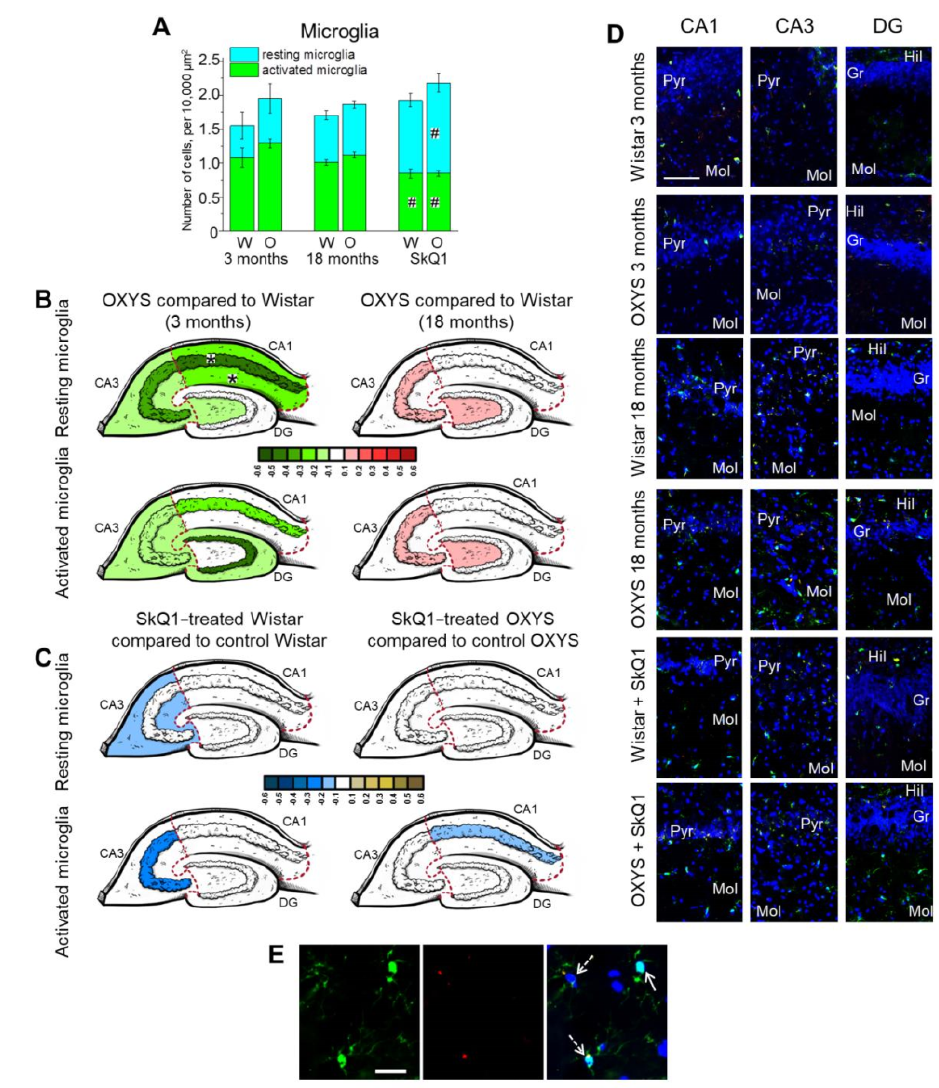
Figure 4. The density of resting and activated microglia in the hippocampus of OXYS and Wistar rats at 3 and 18 months of age, as well as after SkQ1 treatment ( A ). Changes in resting- and activated- microglia density in the regions of hippocampus of OXYS rats compared to Wistar rats ( B ) and in SkQ1-treated compared to untreated animals ( C ) are presented schematically. Cell density in each region and layer is coded as a heatmap on an lg scale from − 0.6 to 0.6. ( D ) An image of Iba1 + cells (green) and CD68 + cells (red) in the hippocampal regions of OXYS and Wistar rats at 3 and 18 months of age, as well as after SkQ1 supplementation. The scale bar is 100 µ m. ( E ) A representative image of Iba1 + cells (green; indicated by the arrow) and CD68 + cells (red; pointed out by the dashed arrow) (the molecular layer of the CA1 area in the hippocampus of a Wistar rat at 3 months of age). The scale bar is 20 µ m. 4 (cid:48) ,6-Diamidino-2-phenylindole (DAPI, blue) indicates cell nuclei ( D , E ). Gr: granular layer; Hil: hilus; Mol: molecular layer; O: OXYS rats; W: Wistar rats; Pyr: pyramidal layer. The data ( A ) are presented as mean ± SEM; # p < 0.05 for effects of SkQ1